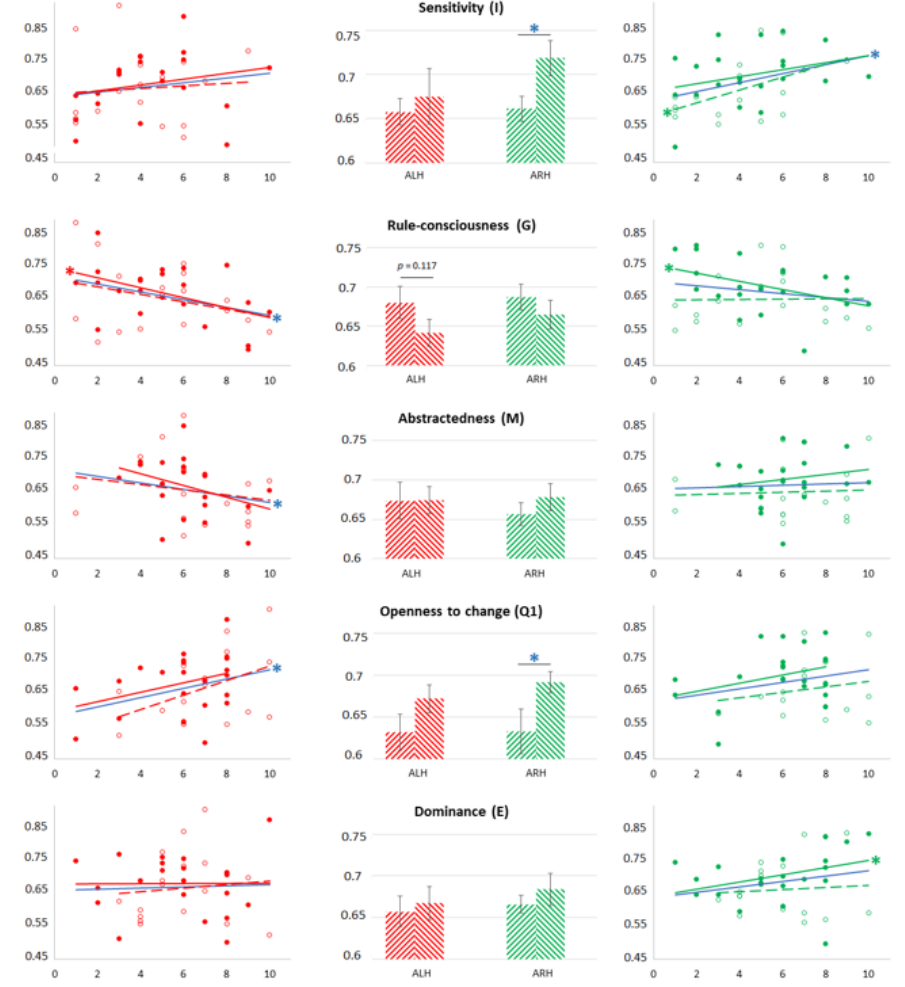
Figure A1. Left and right columns of plots represent the correlation fields between the factor score and the classification accuracy of brain signals during imagination of movements of LH comparative to the rest (ALH, left column) and of RH comparative to the rest (ARH, right column). Filled points and solid trend lines represent the values for “pure” right-handers; empty points and dotted trend lines represent latent left-handers. Significant Pearson’s or Spearman’s correlations ( p < 0.05) are marked with an asterisk (*) (red asterisks stand for ALH in the group of “pure” right-handers or latent left-handers, green stand for ARH, and blue represent ALH or ARH among all participants). The factors are specified on the top of the middle plots. The middle column of the plots represents mean ALH (red columns) and mean ARH (green columns) for the subgroups of participants with the low factor score (low expression of the personality trait; left columns) and with the high score (high expression of the personality trait; right columns). Significant Mann-Whitney’s correlations ( p < 0.05) are marked with blue asterisks (*), p -value is indicated in the case of